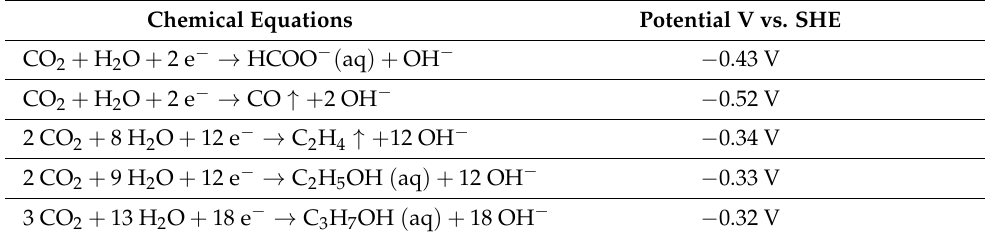
Table 1. CO 2 reduction products on the cathode with their respective potentials at pH 7 [18,19]. Chemical Equations Potential V vs.